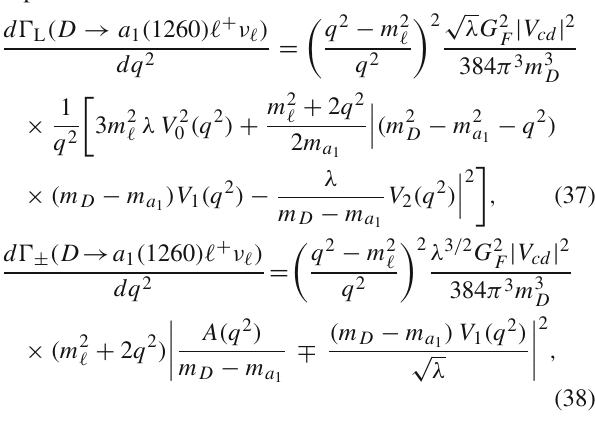
Table 1 The ratios of the continuum states’ and the dimension-six condensates’ contributions over the total moments of a 1 ( 1260 ) -meson (cid:3); n (cid:4)| μ with n = ( 2 , 4 , 6 , 8 , 10 ) within longitudinal twist-2 LCDA (cid:2) ξ 2 ; a 1 the determined Borel windows. The abbreviations “Con.” and “Six.” stand for the continuum and dimension-six contributions, respectively (cid:3); n (cid:4)| n Con. Six. M 2 (cid:2) ξ 2 ; a 1